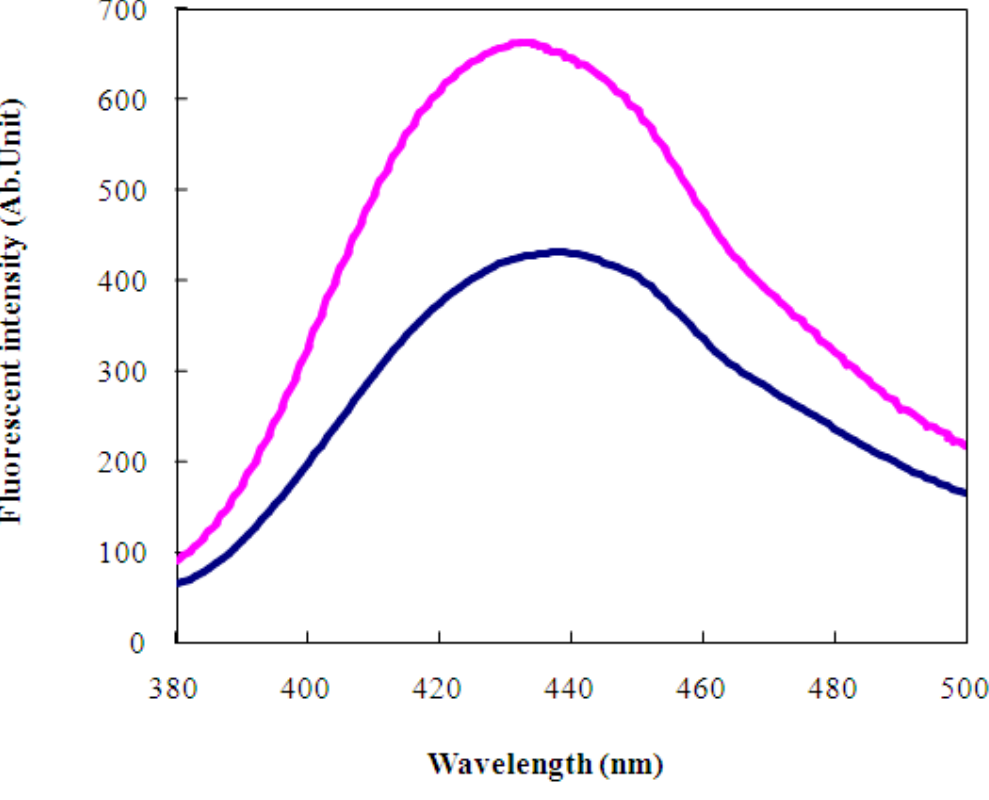
Figure 3. Effect of Leu binding on the fluorescence spectrum of MIANS-conjugated-LIVBP (Gln149Cys-M). The fluorescence emission spectra of MIANS-conjugated LIVBP mutant Gln149Cys (0.4 µM) were determined in the absence (broken line) and presence (solid line) of 4 µM